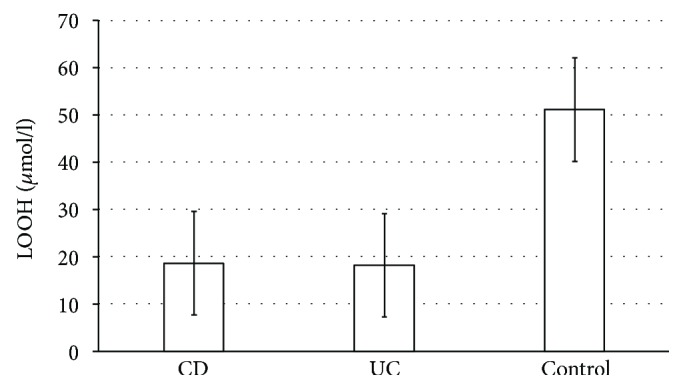
The mean values of LOOH concentrations (μmol/l) depending on the study group (UC, CD, and control group).